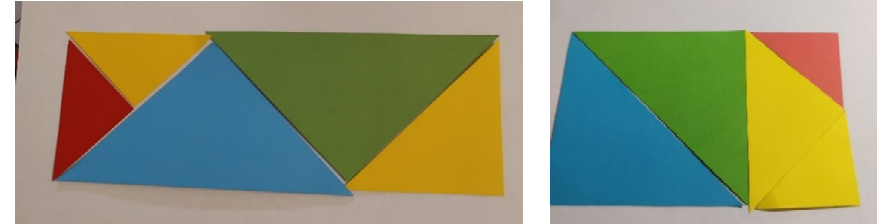
Figure 14. Rectangles with different perimeters.